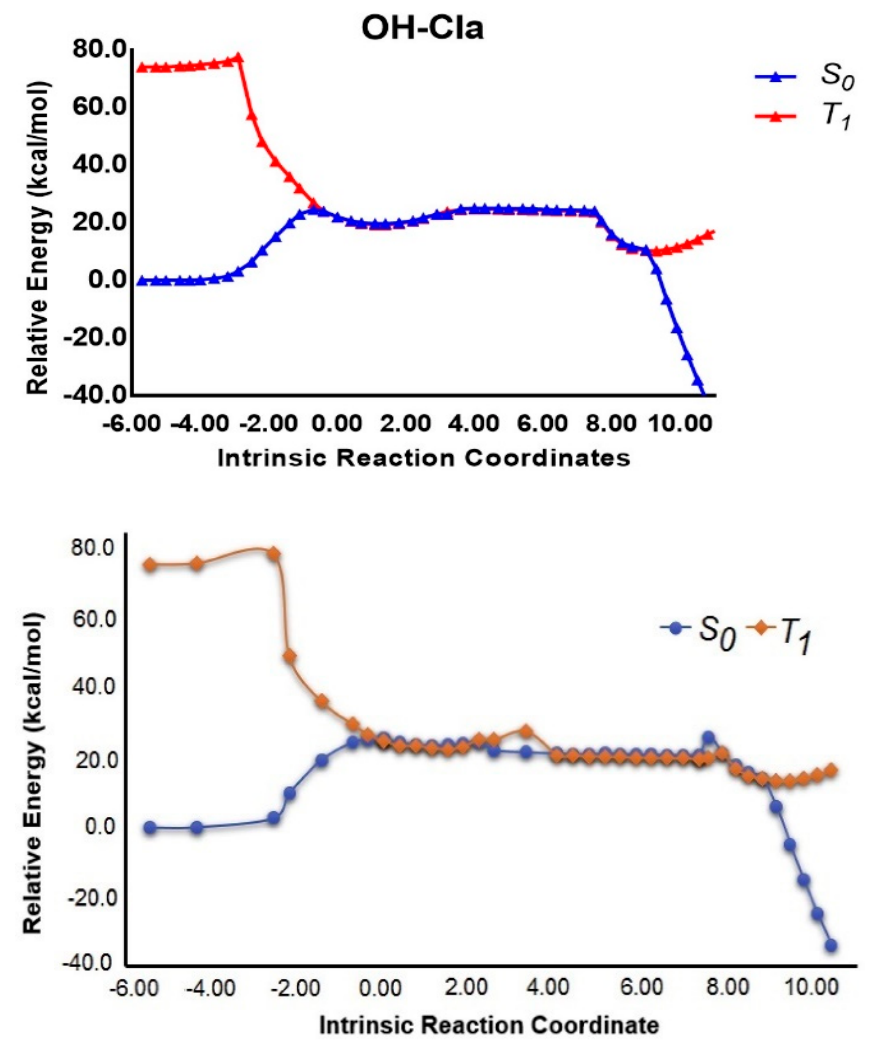
Figure 1. Potential energy curves (in kcal · mol − 1 ) for the S 0 and T 1 states during the thermolysis of OH-Cla (top) and Br-Cla dioxetanones (bottom), as a function of intrinsic reaction coordinates (in amu 1/2 bohr). Calculations were made with the ω B97XD density functional in implicit water. The bottom figure is reprinted with permission from [12]. Copyright Elsevier 2019.